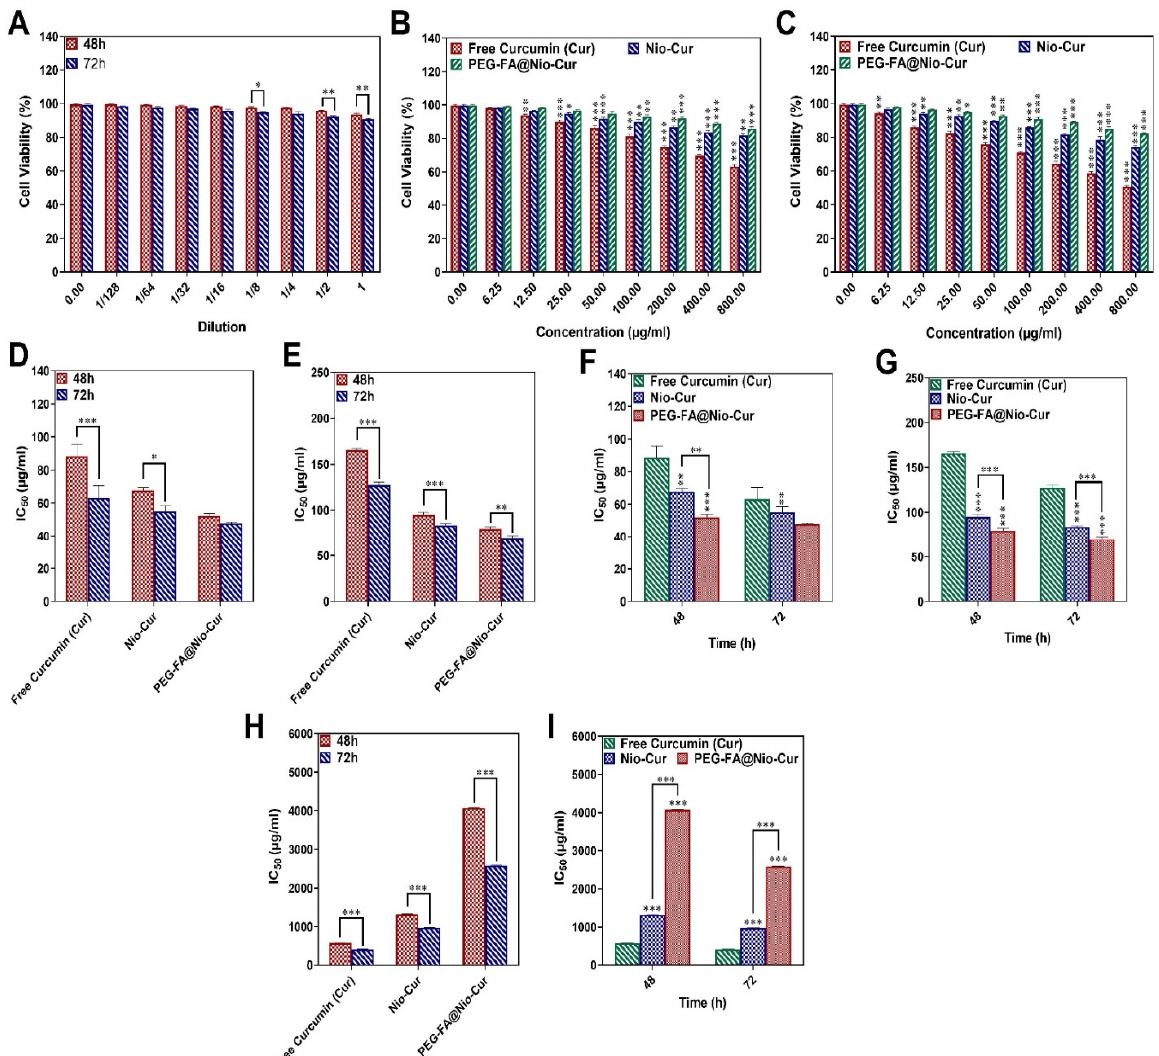
Figure 3. ( A ) Percentage cell viability of different dilutions of vehicle (Nio) on nonmalignant MCF10A cells; ( B ) The effects of Cur, Nio-Cur, and PEG-FA@Nio-Cur on the viability of MCF10A cells in 48 h; ( C ) The effects of Cur, Nio-Cur, and PEG-FA@Nio-Cur on the viability of MCF10A cells in 72 h; ( D ) Half-maximal inhibitory concentration (IC50) values after 48 h and 72 h exposure of MCF7 breast cancer cells to Cur, Nio-Cur, and PEG-FA@Nio-Cur; ( E ) Half-maximal inhibitory concentration (IC50) values after 48 h and 72 h exposure of 4T1 breast cancer cells to Cur, Nio-Cur, and PEG-FA@Nio-Cur; ( F ) Comparison of in vitro cytotoxic impacts of all samples in MCF7 breast cancer